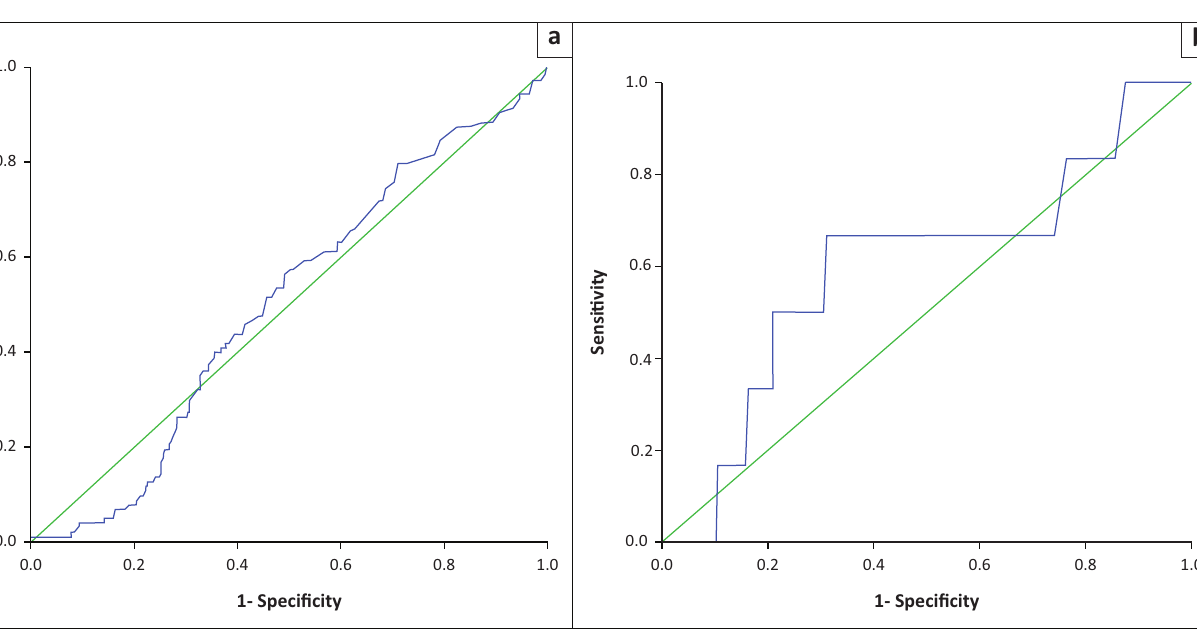
FIGURE 2: Red cell distribution width ROC curve in sickle cell triat phenotypes (haemoglobin AS genotype and β-thalassaemia) in western Kenya, 01 January 2015 – 31 December 2020 . (a) Red cell distribution width, receiver operating characteristic curve for sickle cell trait flowing along diagonal line of the ROC curve. (b) Red cell distribution width, receiver operating characteristic curve for sickle cell trait+β-thalassaemia also flowing along the diagonal line of the ROC